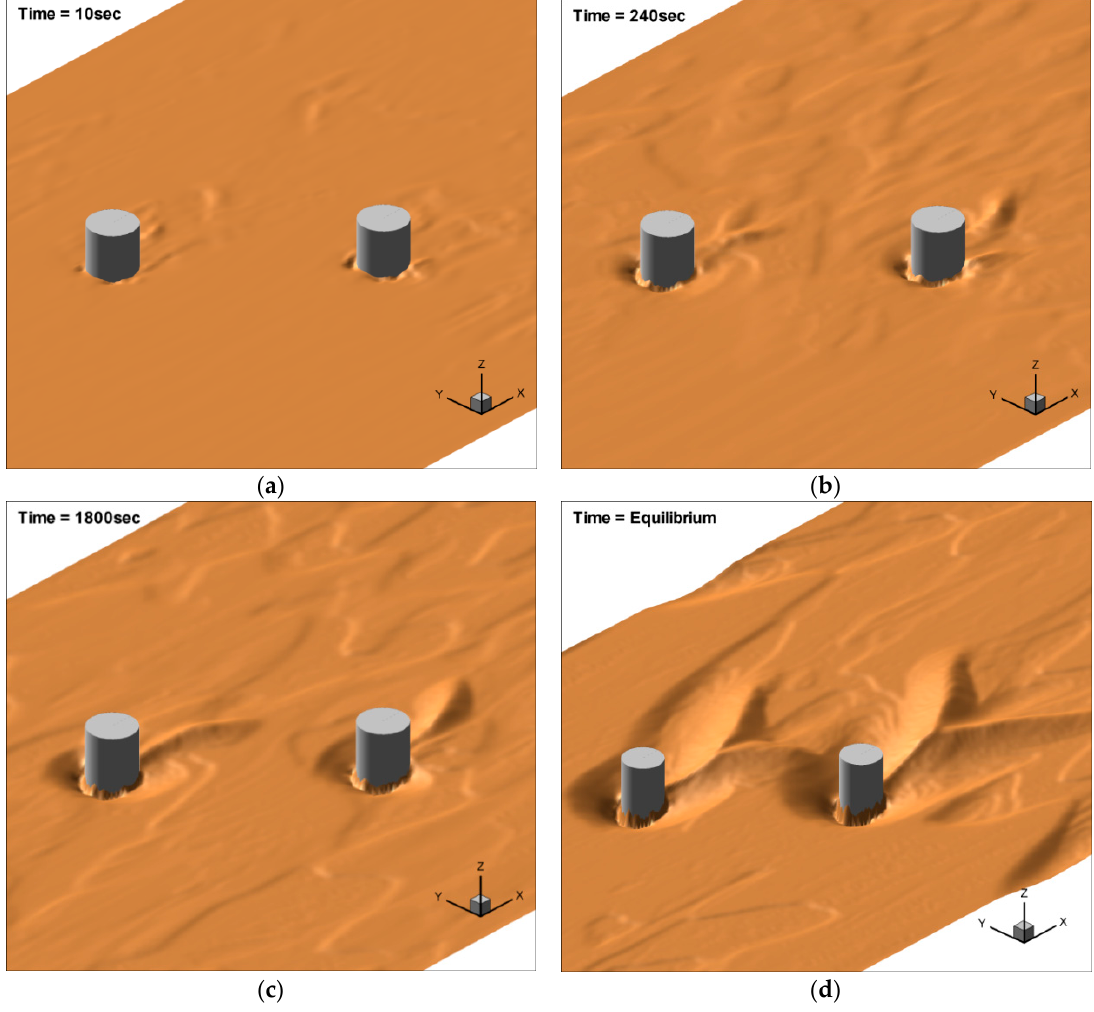
Figure 7. Instantaneous views of the bed elevation for an alignment angle of 45° with s / D = 5.0 at 10 s, 240 s, 1800 s and final time: ( a ) Time = 10 s; ( b ) Time = 240 s; ( c ) Time = 1800 s; ( d ) Time = Equilibrium.